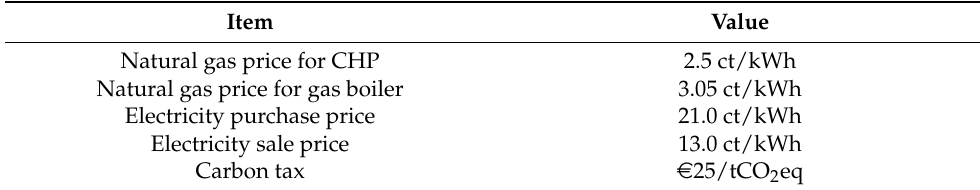
Table 2. Electricity, natural gas and carbon tax prices used in this